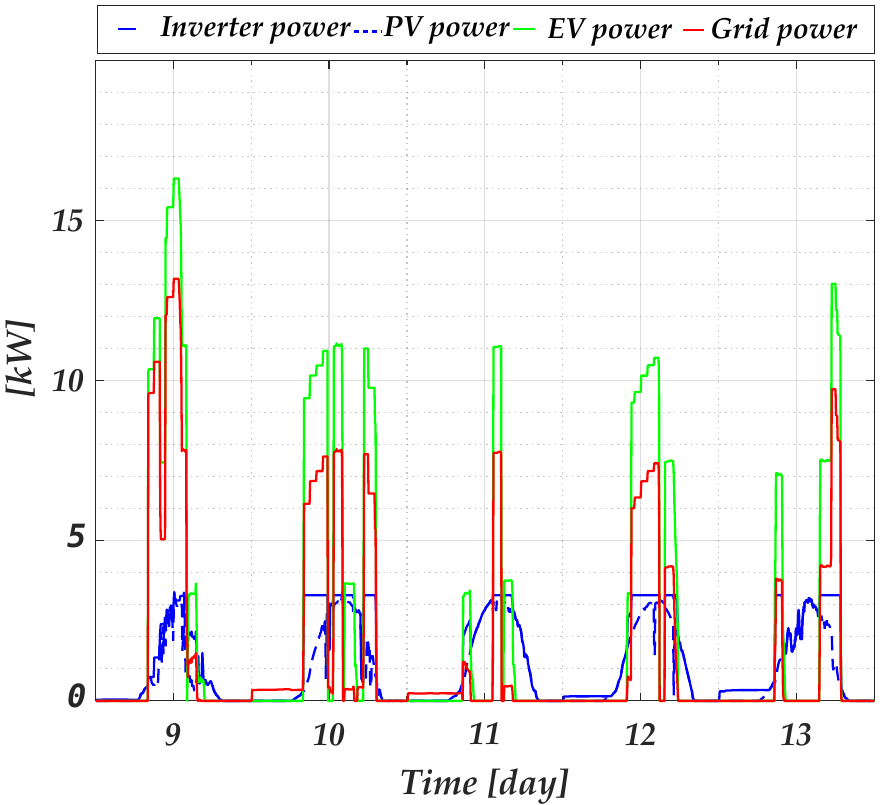
Figure 6. Real-time power profile of the charging station (9th to 13th of May